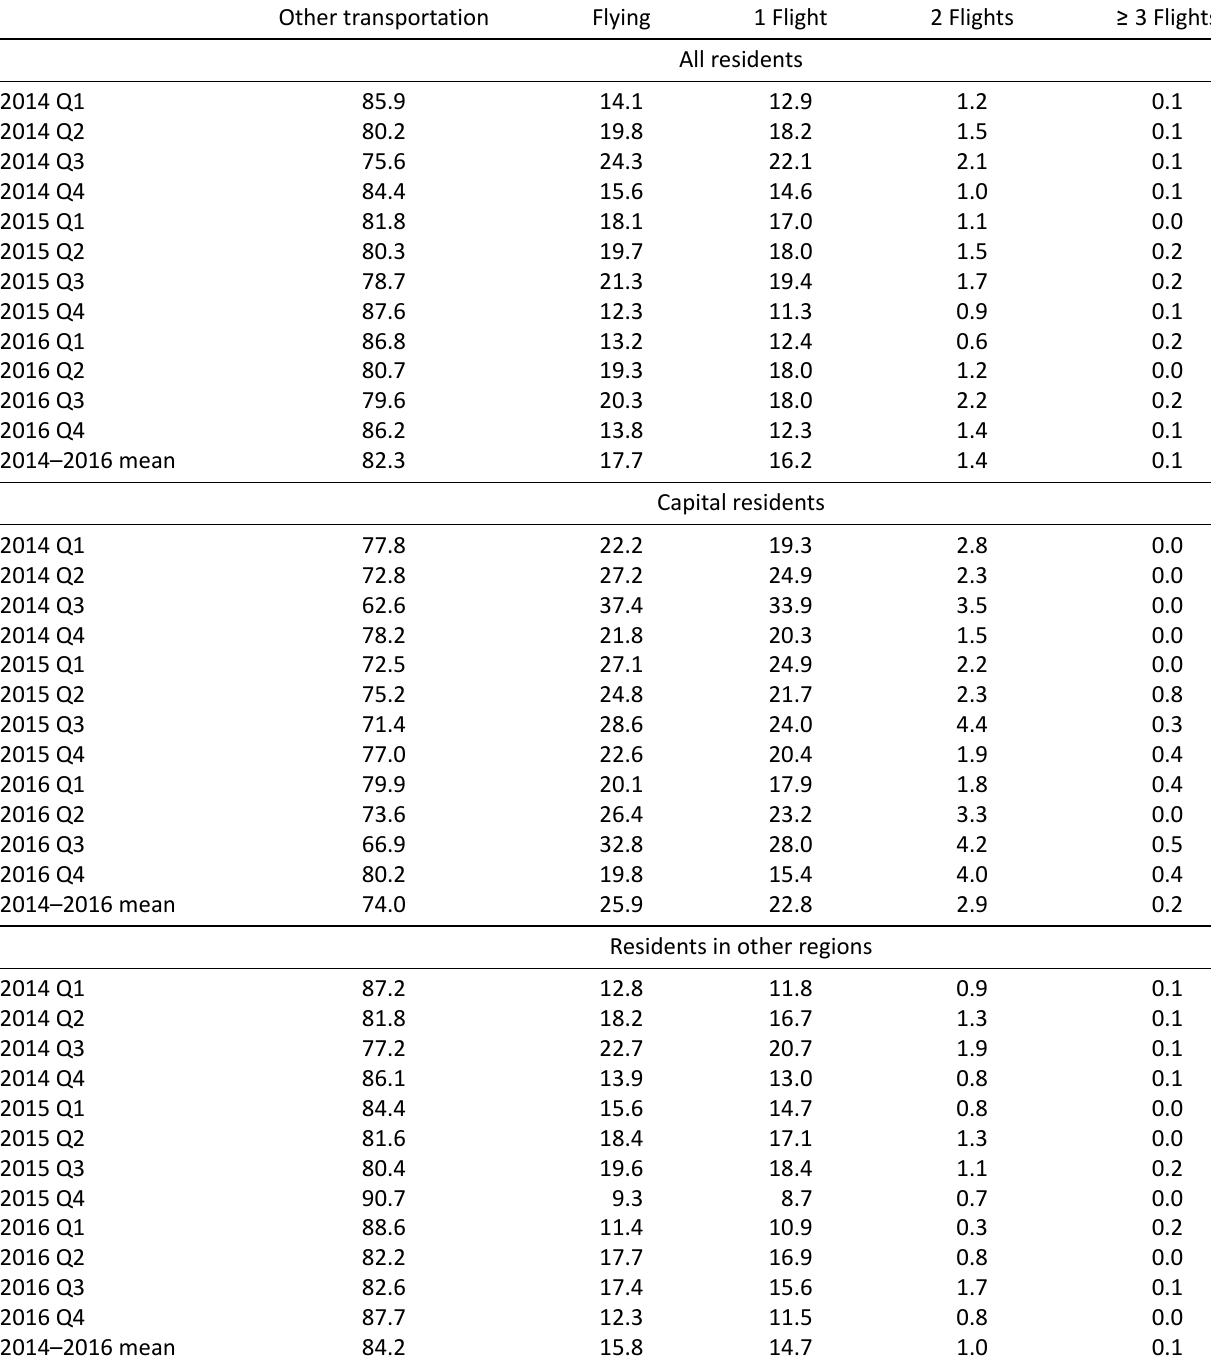
Table 1. Proportion of persons flying to their holiday destinations 2014–2016